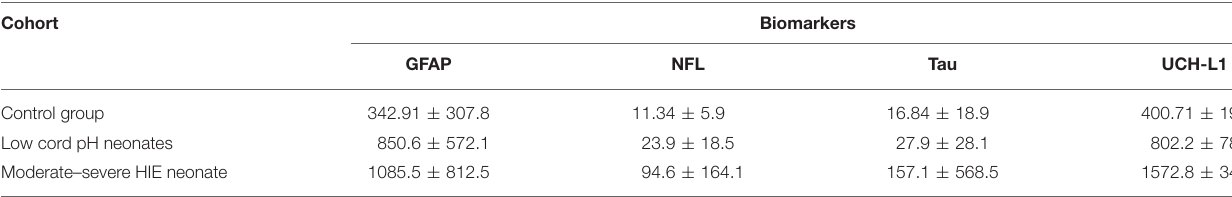
TABLE 3 | Comparison of Mean values of biomarker concentration among 3